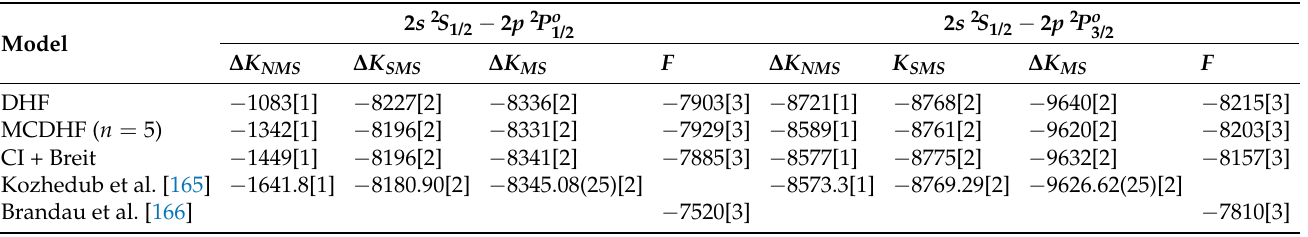
Table 6. Relativistic mass shift ∆ K MS (in GHz u) and field shift F (in MHz/fm 2 ) factors for